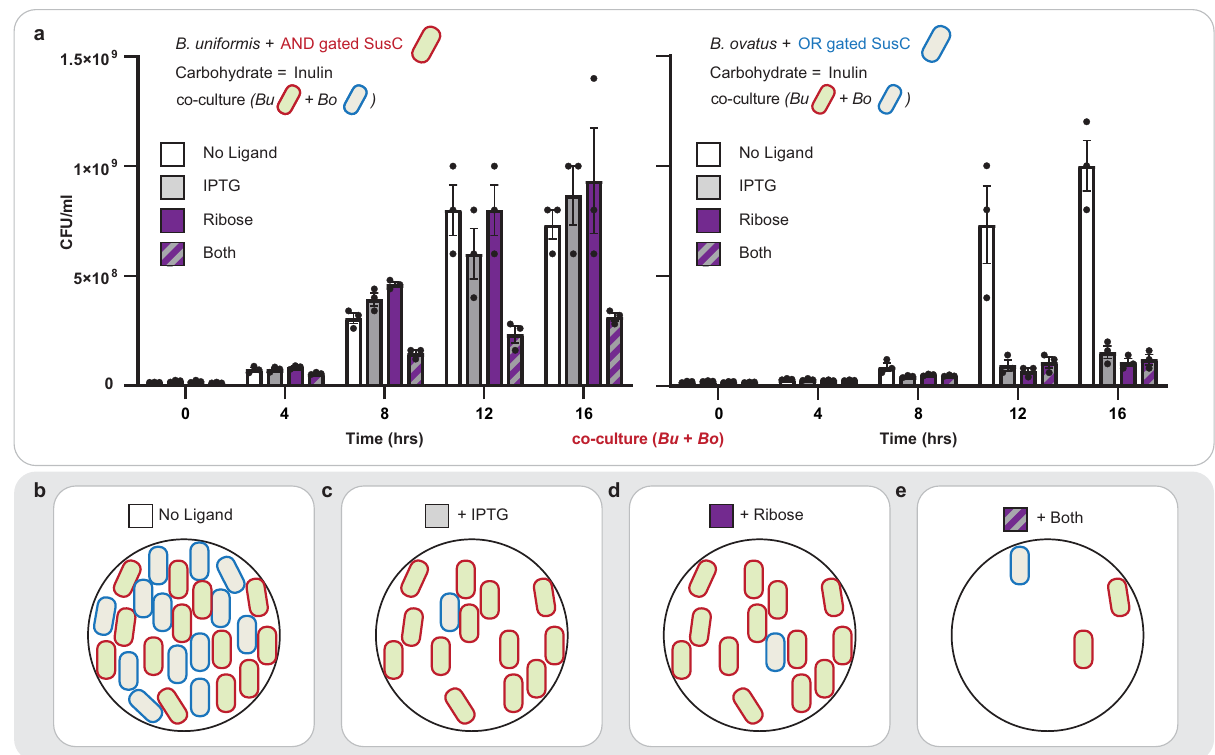
Fig. 6 Controlling community composition in co-culture. a Demonstration of asymmetric programming of two species in co-culture. The B. uniformis strain described in Fig. 5a was co-cultured with the B. ovatus strain described in Fig. 5c in inulin minimal media. Each strain was intentionally constructed to harbor a different antibiotic resistance so that they could be differentiated when plated on BHI agar with appropriate antibiotics. The left bar chart shows the density of the B. uniformis strain over time as calculated by dilution plating (Methods). The right bar chart shows the density of B. ovatus over time. Four co- cultures were grown in parallel, each with a different combination of inducers. White bars represent medium with no ligand, gray bars represent medium with 10 mM IPTG, purple bars represent medium with 1 mM D-ribose, and striped bars represent medium with both inducers. b Cartoon illustrating the co- culture composition with no ligand present in the medium. c Cartoon illustrating the co-culture composition with IPTG present in the medium. d Cartoon illustrating the co-culture composition with D-ribose present in the medium. e Cartoon illustrating the co-culture composition with both IPTG and D-ribose present in the medium. Source data are provided as a Source Data fi le. Data represent the average of n = 3 technical replicates (see Supplementary Fig. 9 for additional data and information). Error bars correspond to the SEM of these